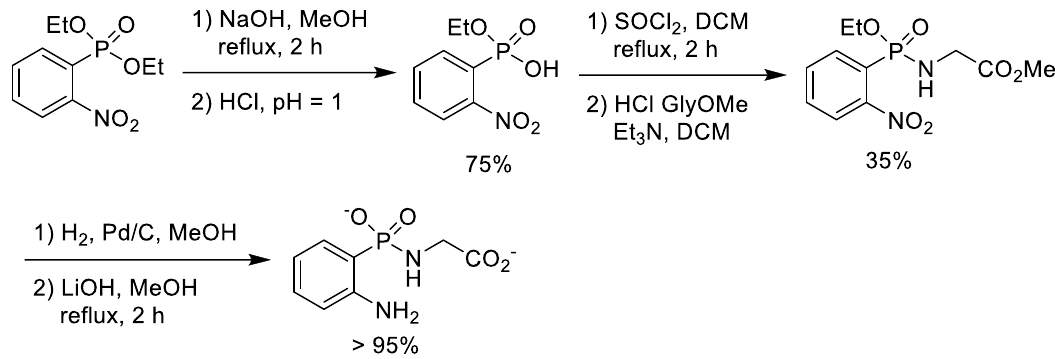
Scheme 11. Synthesis of β-phosphonopeptide containing aromatic N -terminal amino